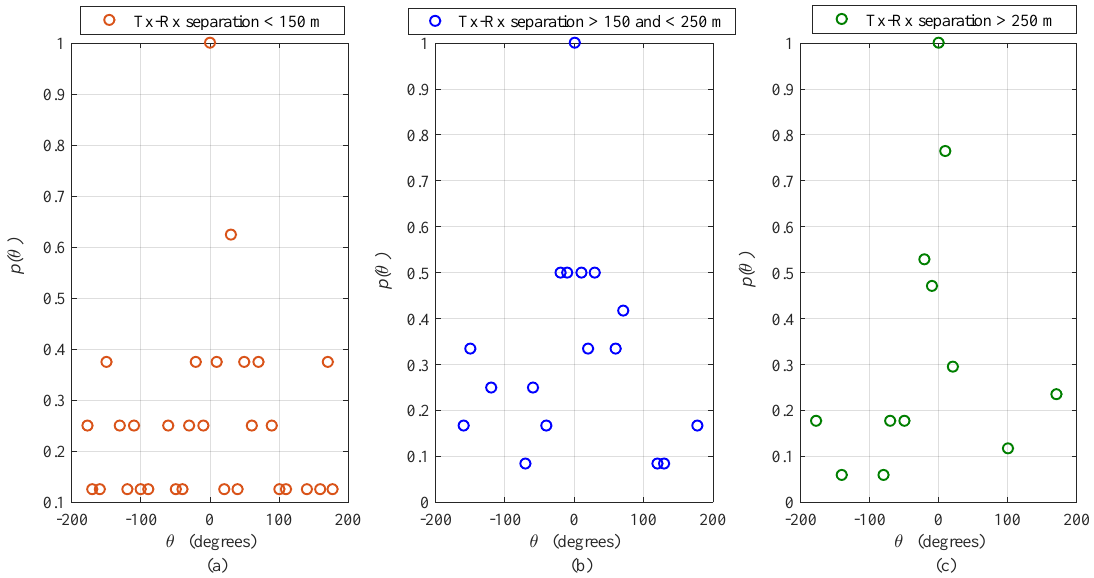
Figure 1. Angular distribution of multipath power with respect to azimuth angle of arrival (AoA) for different outdoor mmWave (38 GHz) radio propagation environments; obtained after data calibrations, and normalization operations performed on the measurement results provided in [4]. ( a ) Tx-Rx separation < 150 m; ( b ) Tx-Rx separation > 150 and < 250 m; ( c ) Tx-Rx separation > 250 m Figure 7 of [4].